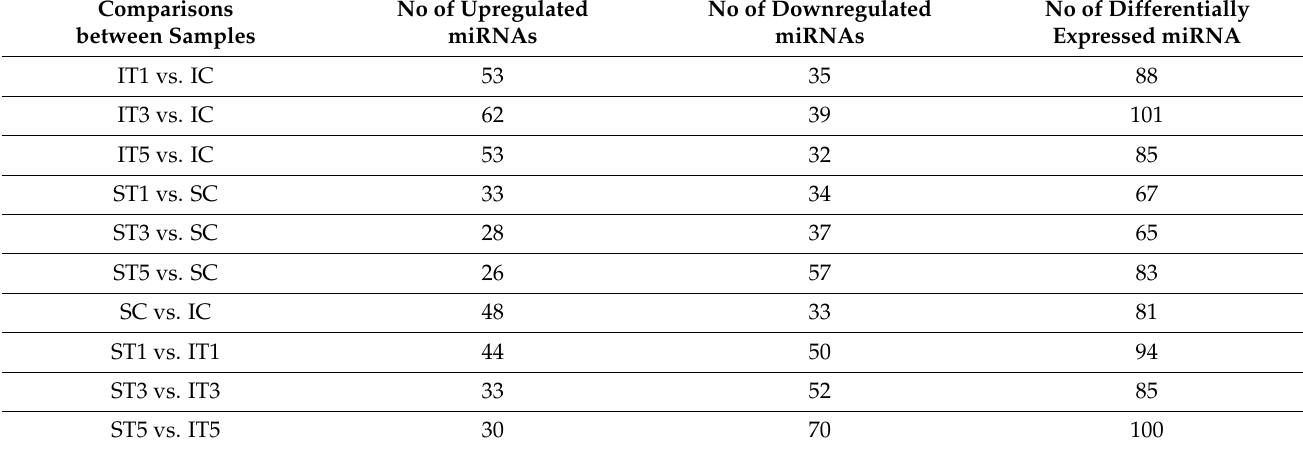
Table 2. Differentially expressed miRNAs statistics identified through small RNA NGS data